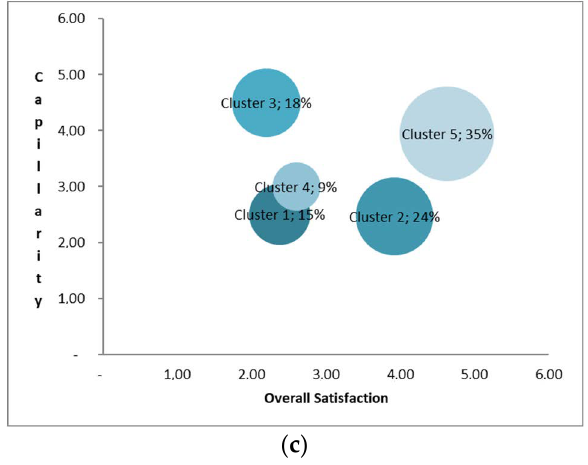
Figure 4. ( a ) Sensitivity of tourists to price. ( b ) Sensitivity of residents to comfort. ( c ) Sensitivity of residents to capillarity.